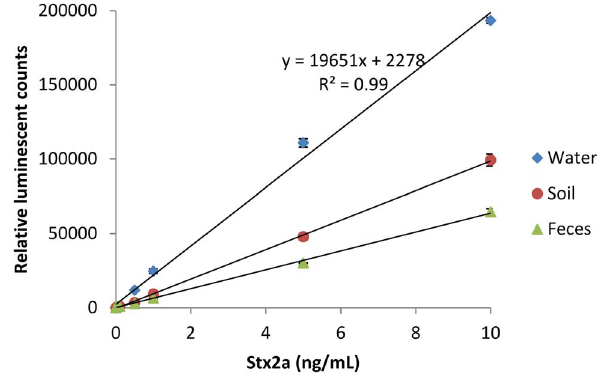
Figure 5. Detection of Stx2a spiked in water ( ) and broth of soil ( ) and feces ( m ) by a sandwich ELISA using Stx2-pAb as capture antibody (1 m g/mL) and HRP conjugated Stx2-pAb as detector antibody (100 ng/mL). Data represent the average of three determinations 6 SD.